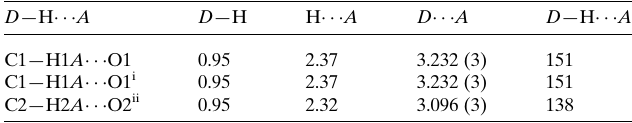
Table 1 Hydrogen-bond geometry (A˚ , (cid:4) ).